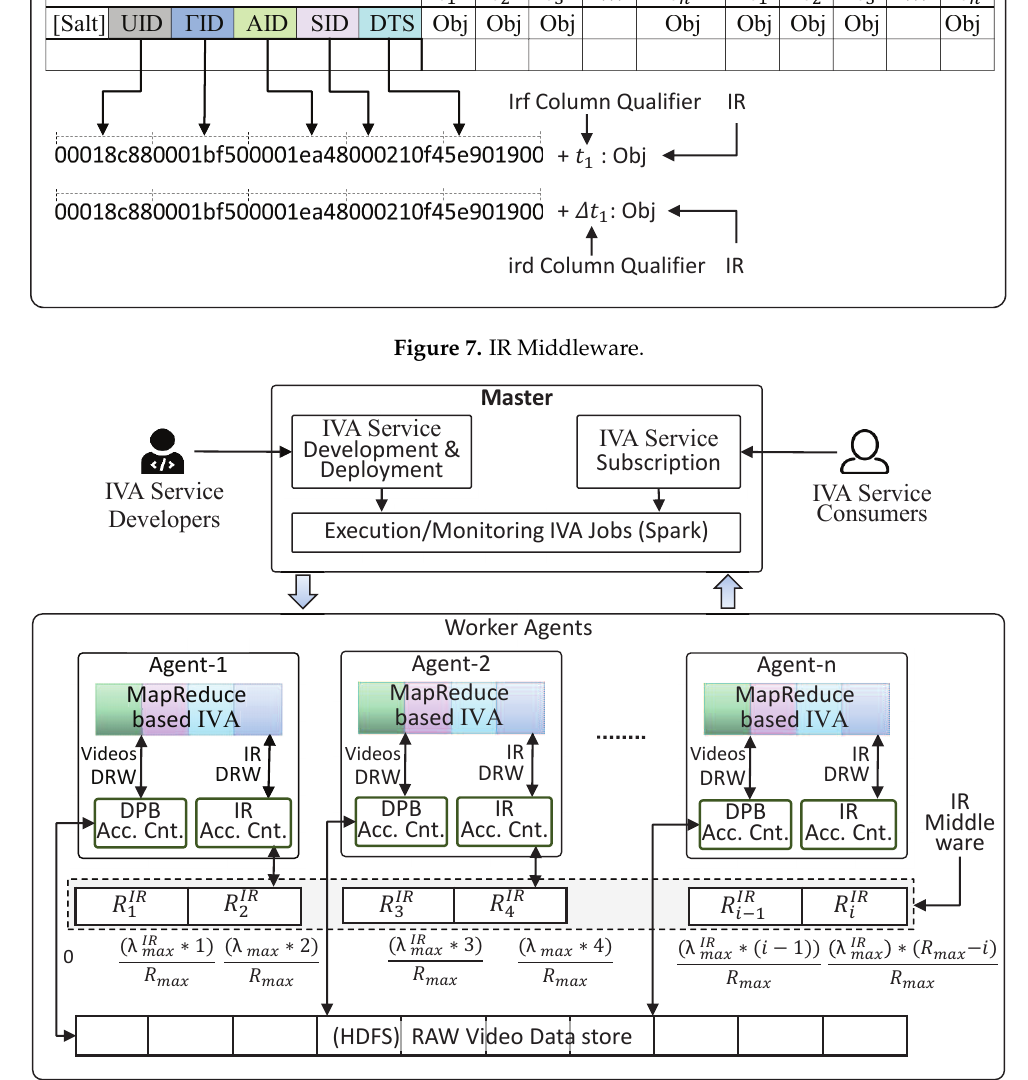
Figure 8. Working of Distributed Persistent Big Data Store (DPBDS) and Immediate Structure Big Data Store (ISBDS) Access Controllers in spark cluster